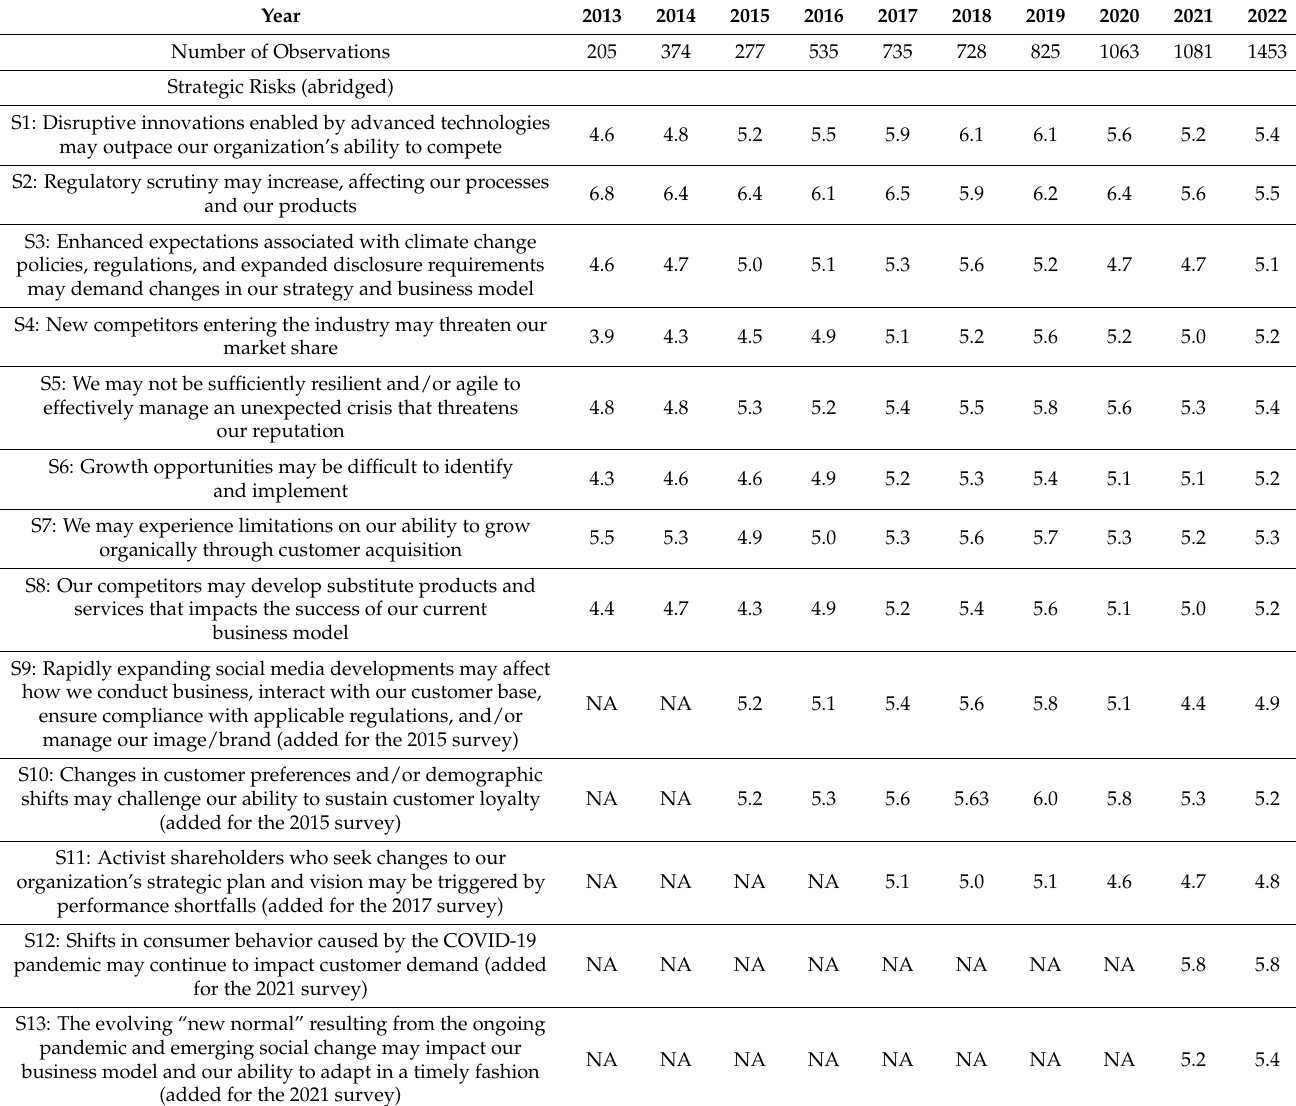
Table 7. Survey Responses for Strategic Risk